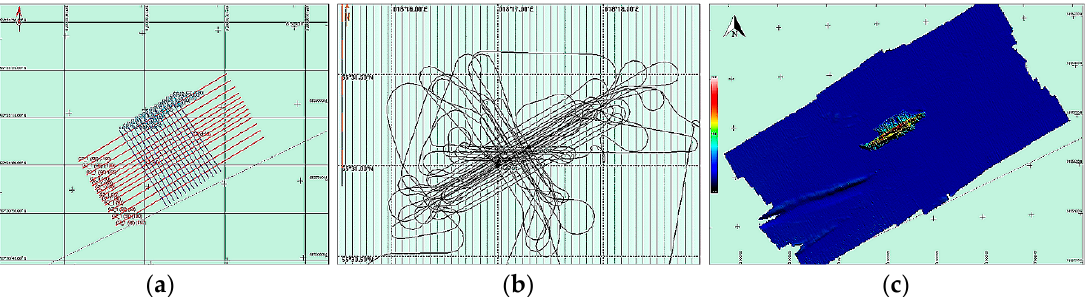
Figure 3. Planning of hydrographic survey and maneuvering around the aircraft carrier wreckage: ( a ) designing a measurement profile system; ( b ) diagram of the ship maneuvering in the wreckage area; ( c ) a multibeam data grid.